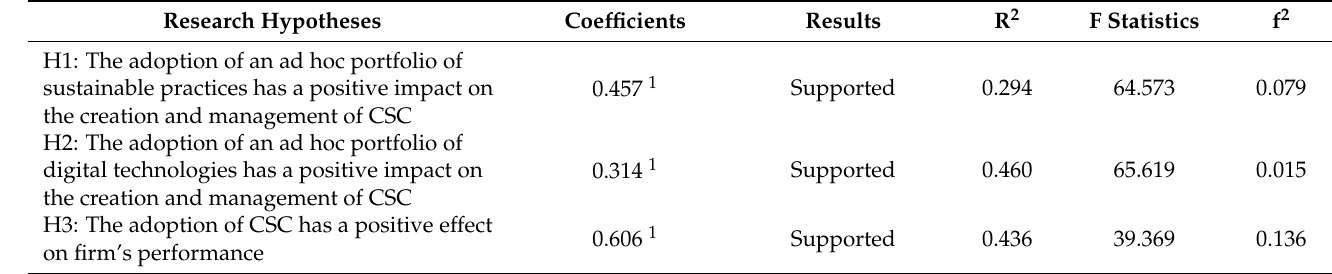
Table 4. Results of the research hypotheses.